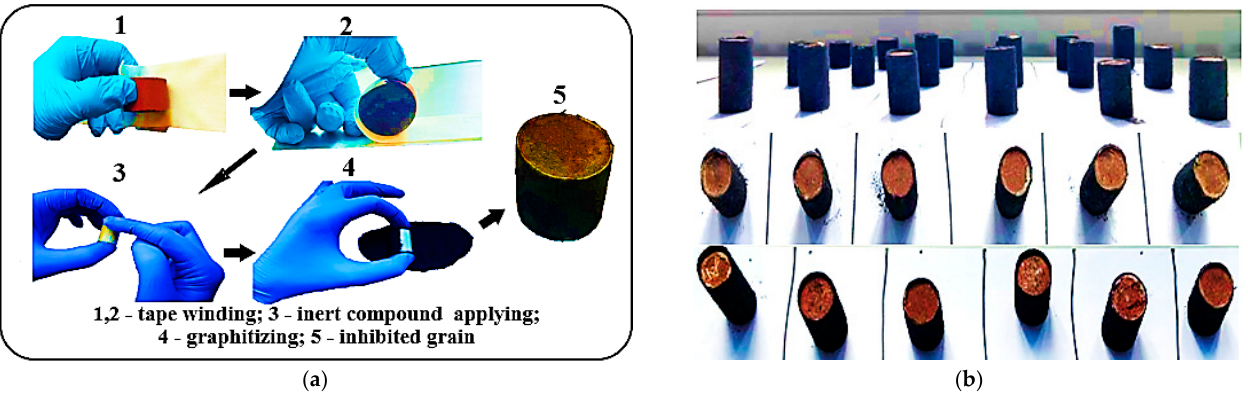
Figure 9. Inhibition process of cylindrical grain propellants. ( a ) Inhibition stages; ( b ) inhibited samples.